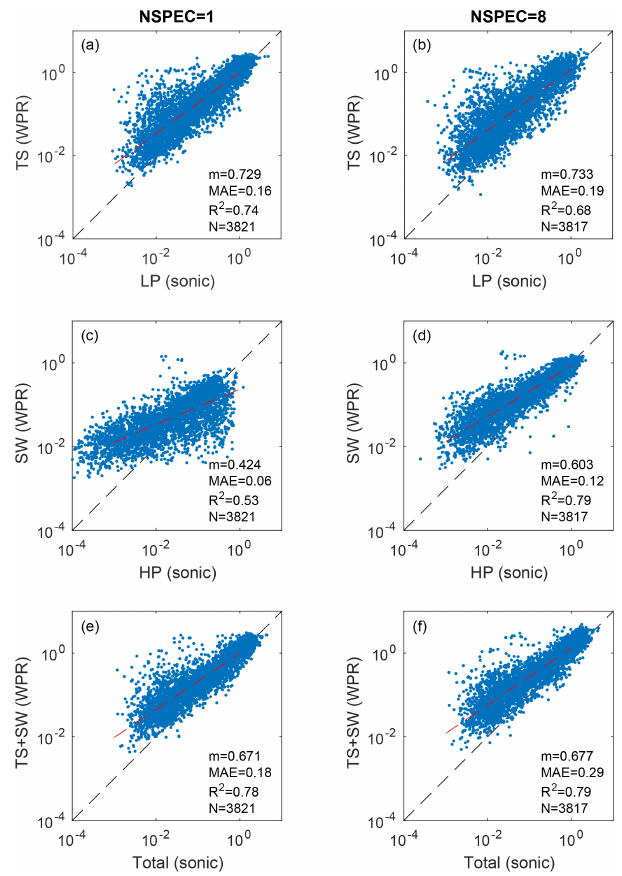
Figure 5. Scatter plots of 30min vertical velocity variance be- tween the sonic anemometers and the 449MHz WPR at overlapped heights of 150, 200, 250, and 300m, for the 2 months of radar measurements: (a, b) low-passed variance from sonic anemometers (LP) versus WPR time series of vertical velocity (TS); (c, d) high- passed variance from sonic anemometers (HP) versus variance from WPR spectral widths (SW); (e, f) total variance from sonic anemometers versus the sum of TS and SW from the WPR. In pan- els (a) , (c) , and (e) , no averaging was performed on the WPR spec- tra, producing a dwell time of 13s, and in panels (b) , (d) , and (f) NSPEC = 8, generating a dwell time of approximately 2min. The slopes of the best fit lines (red dashed lines), mean absolute errors, R 2 values, and number of points, N , are shown for each